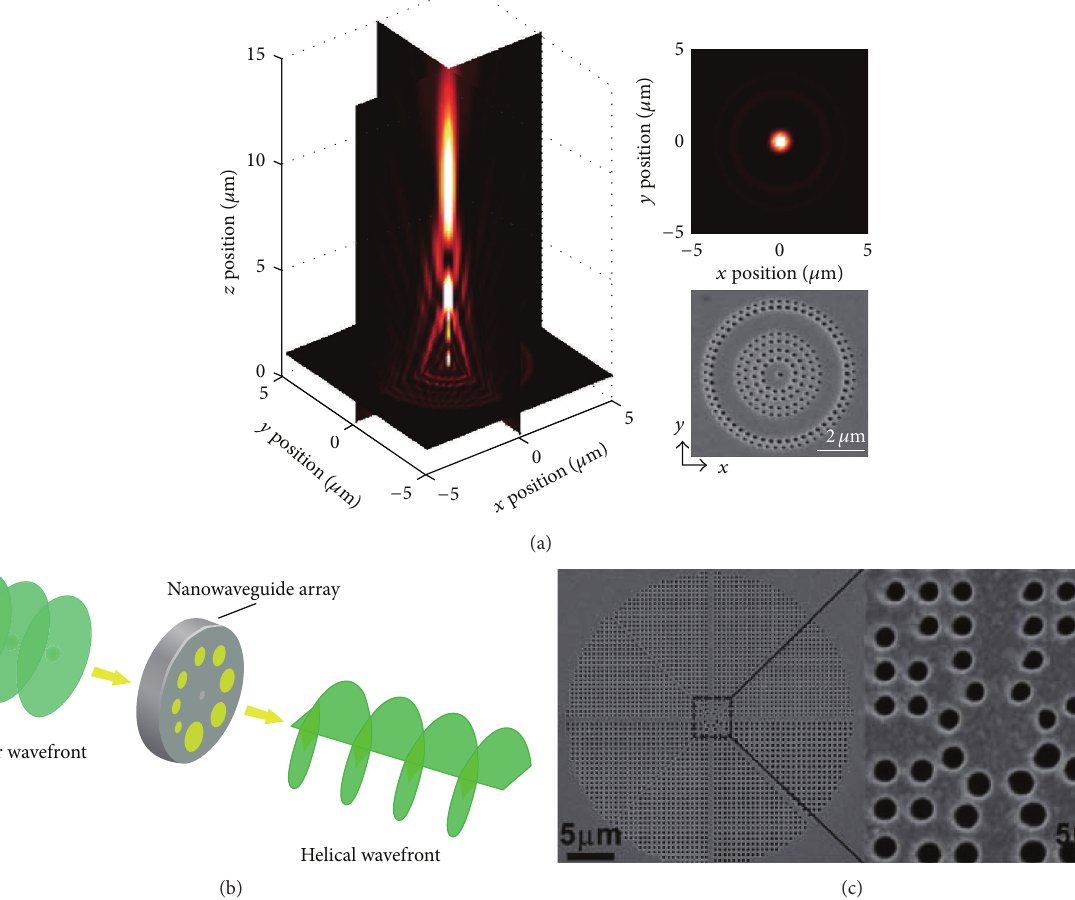
Figure 24: (a) Pseudocolor intensity map calculated from the analytical model of the sample. The color scale is normalized to the maximum intensity. The inset shows the beam cross section at the focal point ( 𝑧 = 10 𝜇 m) and the SEM image of the sample. (b) Schematic of a nanowaveguide array that induces wavefront shaping for OAM generation. (c) SEM picture of the nanowaveguide array. Figures are reproduced from [136,